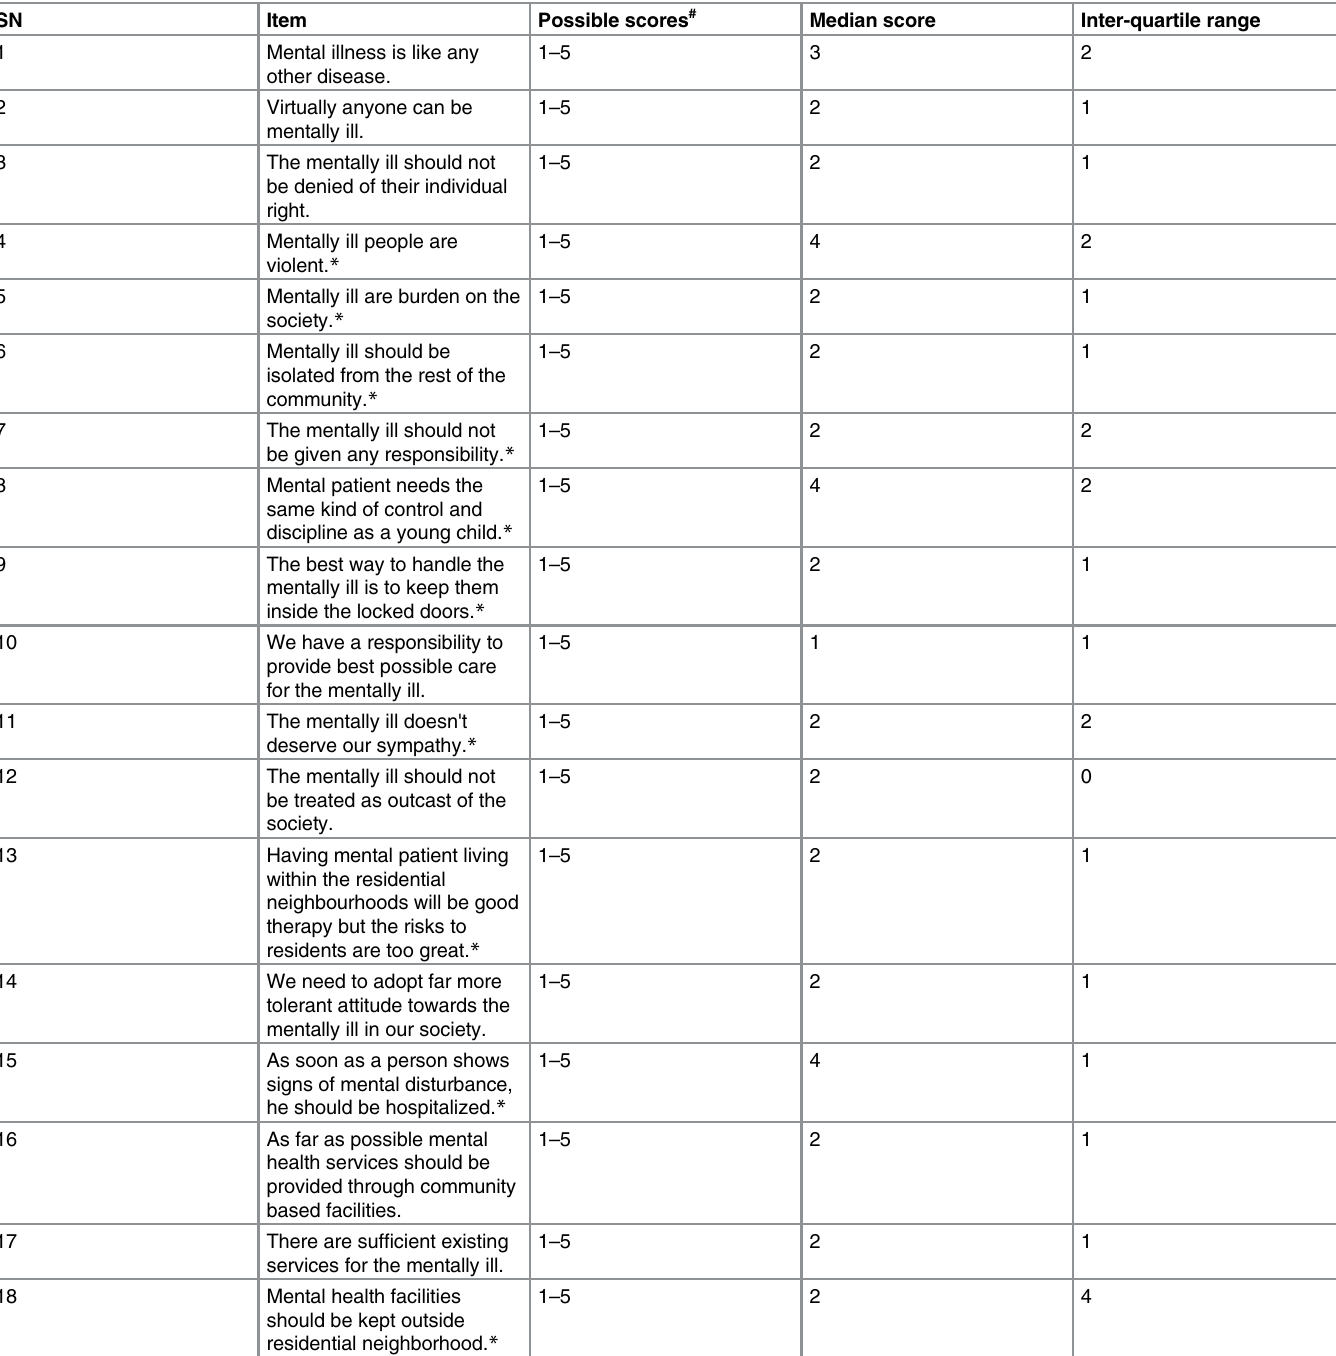
Table 2. Median score of items measuring attitude towards